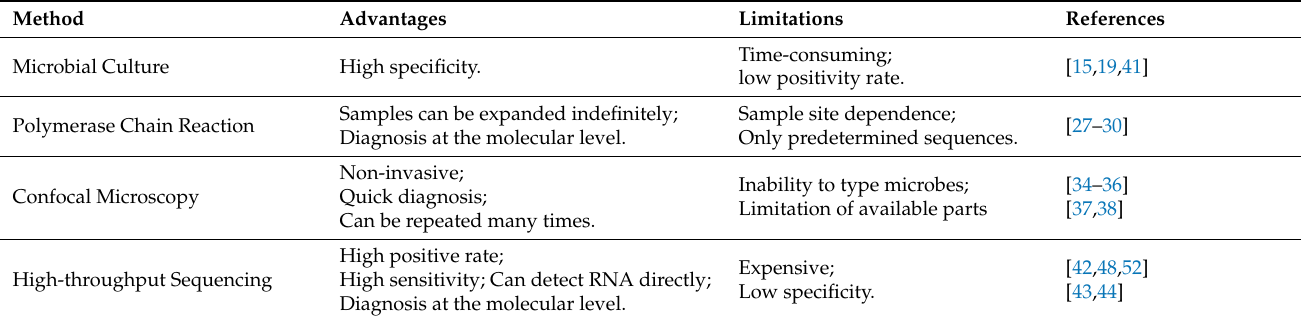
Table 3. Comparison of methods to identify the etiology of eye